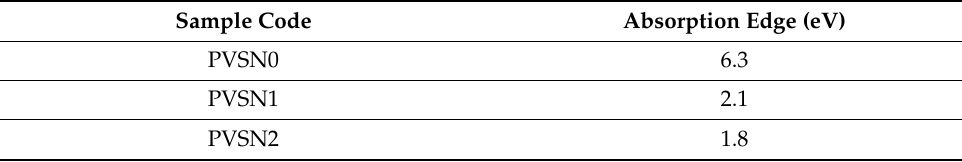
Figure 7. Absorption coefficient vs. h υ for PVA and loaded films. Table 1. Absorption edge for PVA and loaded films.